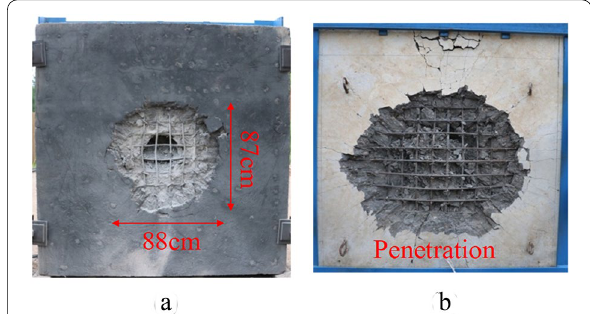
Fig. 14 FC00 slab under 9.6 kg explosion: a the frontal surface and b the back